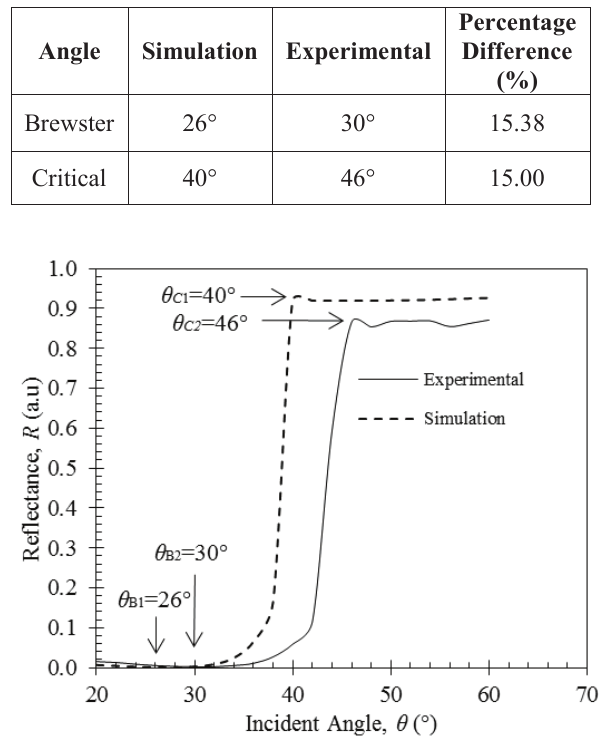
Table 1. Values of Brewster angle and critical angle obtained by simulation and experimental approaches